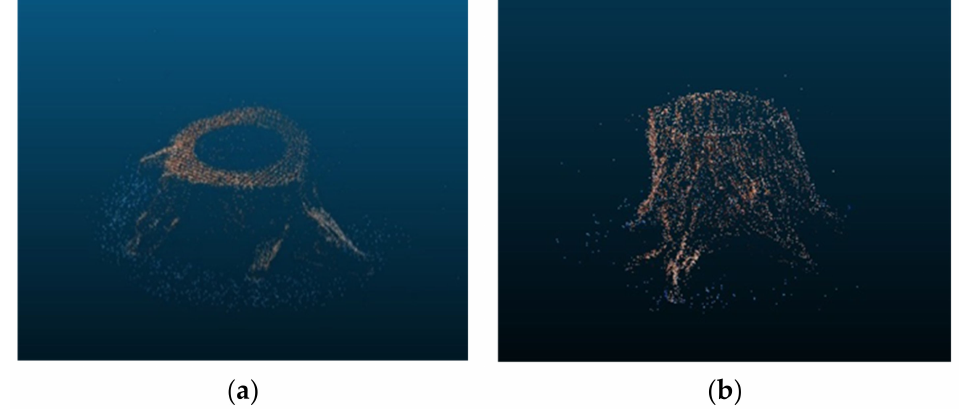
Figure 12. Sparse reconstruction results based on comprehensive SFM: ( a ) sparse reconstruction results of image set 1; and ( b ) sparse reconstruction results of image set